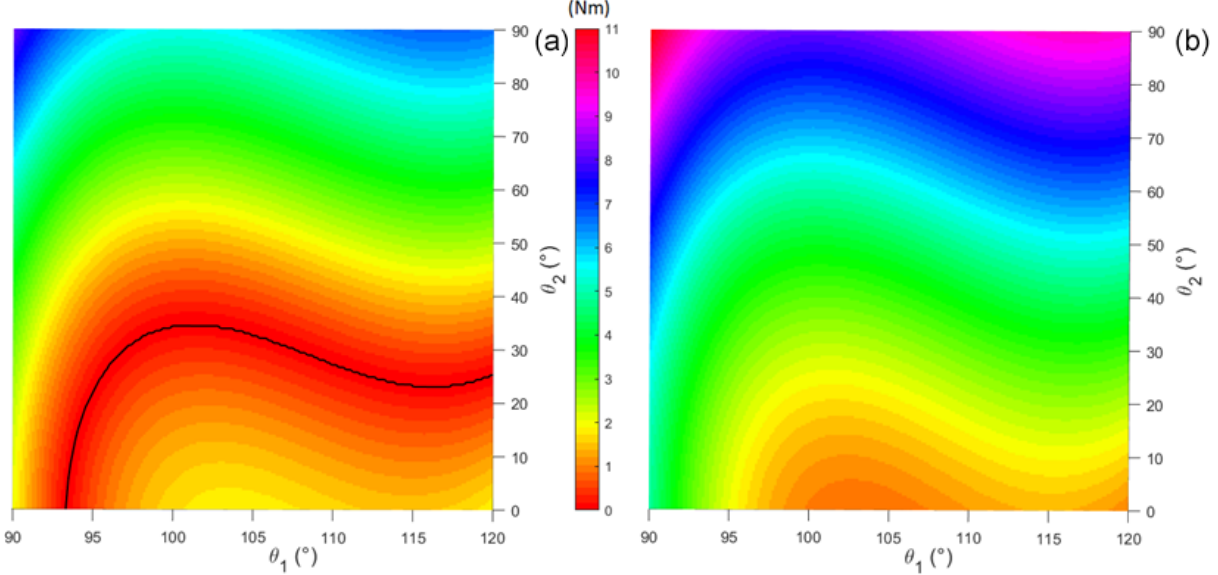
Figure 11. Surface of the absolute difference of the torque due to gravity, in the loaded condition, and the torque generated by the DMSP- 10-100N PAM, projected on plane π : (cid:49) Torque = 0, by employing the shoulder pad at pressures of 7 (a) and 8bar (b)